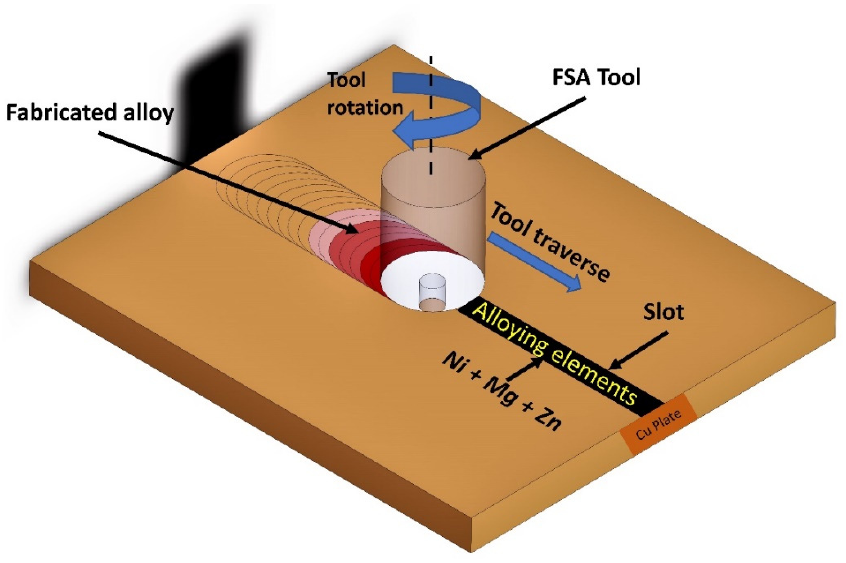
Figure 1. Schematic diagram of FSA.